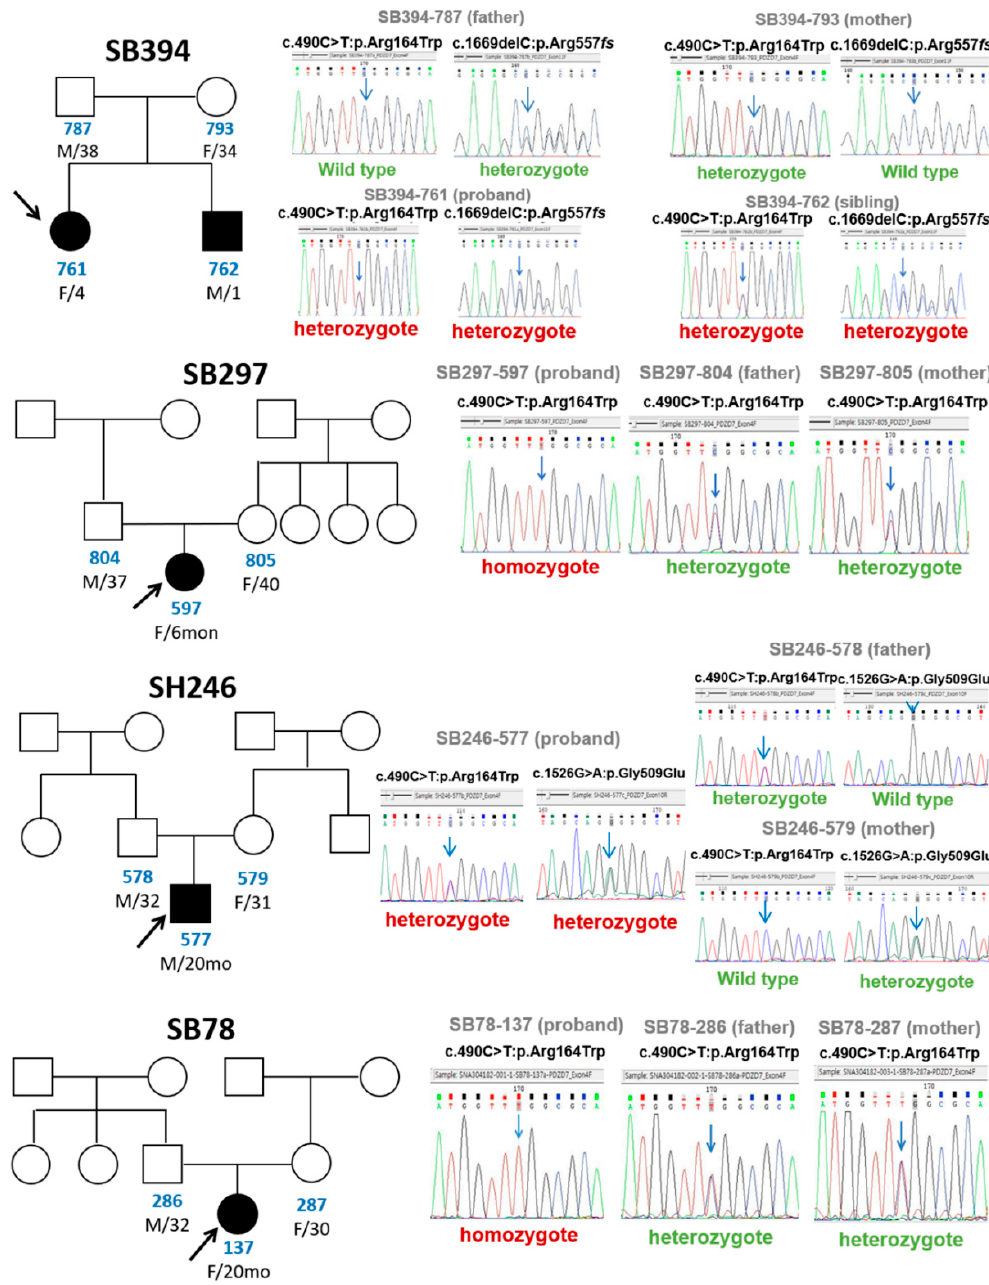
Figure 3. Pedigrees and sanger sequence chromatograms for families segregating mutations in PDZD7. Males are denoted with squares and females with circles. Solid shapes with an arrow are individuals with reported hearing loss (proband). Sanger sequencing demonstrates each mutation in the chromatogram from affected individuals and heterozygous variant from unaffected parents.